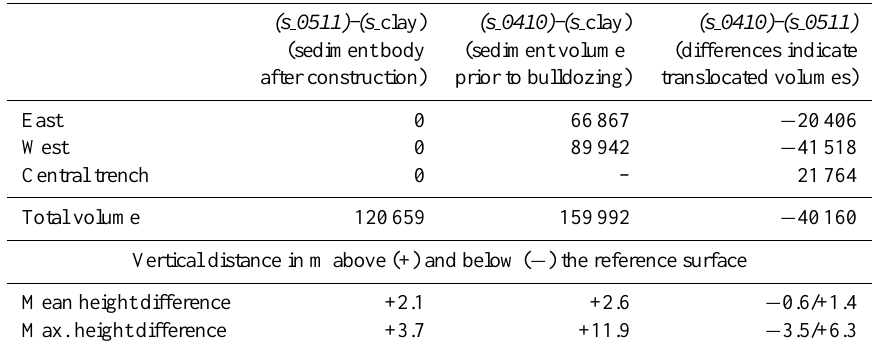
Table 5. Deposited and translocated sediment volumes during Chicken Creek construction as calculated in GOCAD. Positive values indicate that the surface during construction (when material was piled up) lies above the reference surface (i.e. the final bulldozed surface). Negative values indicate that the construction surface is below the reference surface (e.g. due to the filling of the central trench). Volume difference in m 3 in relation to the sediment body after construction (sediment body (sediment volume (differences indicate after construction) prior to bulldozing) translocated volumes) East 0 Central trench – Total volume Vertical distance in m above (+) and below ( − ) the reference surface Mean height difference +2.1